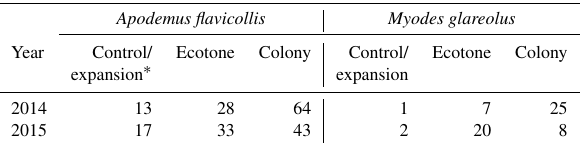
Table 1. Numbers of trapped individuals of the two dominant small mammal species in the Juodkrant˙e great cormorant colony in 2014 (before colony expansion) and in 2015 (the year colony